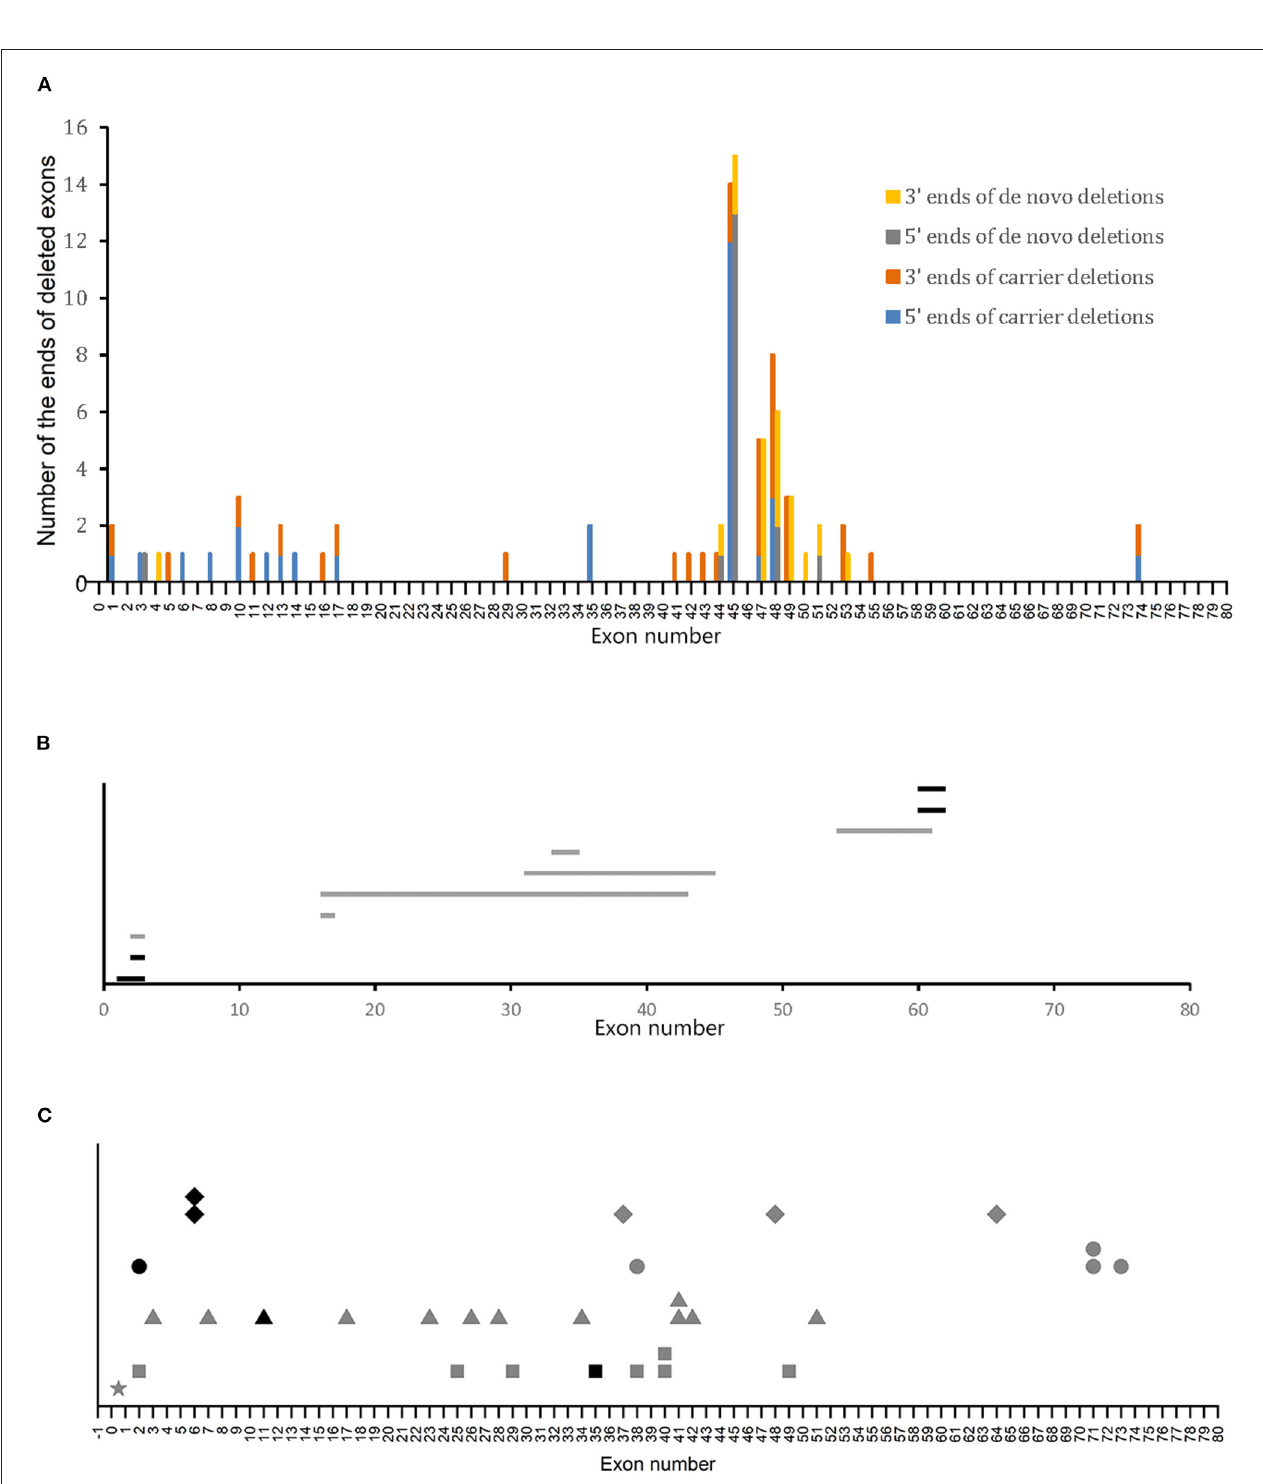
FIGURE 3 | Variant sites in patients with BMD. (A) Distribution of deletion ends in patients with BMD. (B) Distribution of duplications in patients with BMD. Horizontal bars represent the duplicated regions. Gray and black bars represent carrier and de novo variants, respectively. (C) Distribution of small mutations. Gray and black symbols represent carrier and de novo variants, respectively. Squares, triangles, circles, and rhombus represent non-sense mutations, splice site mutations, small deletions/insertions, and missense mutations, respectively. The star represents a point mutation (c.-54T > A) in the 5 ′ -untranslated region (UTR).